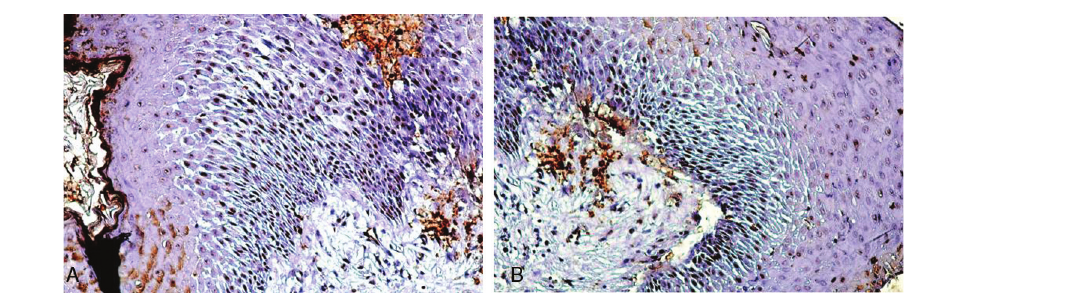
Note the difference in the numbers of positive cells in the matrix of cholesteatoma in (left) children and (right) adults. (EGF monoclonal antibody, streptavidin-peroxidase technique, ×100).